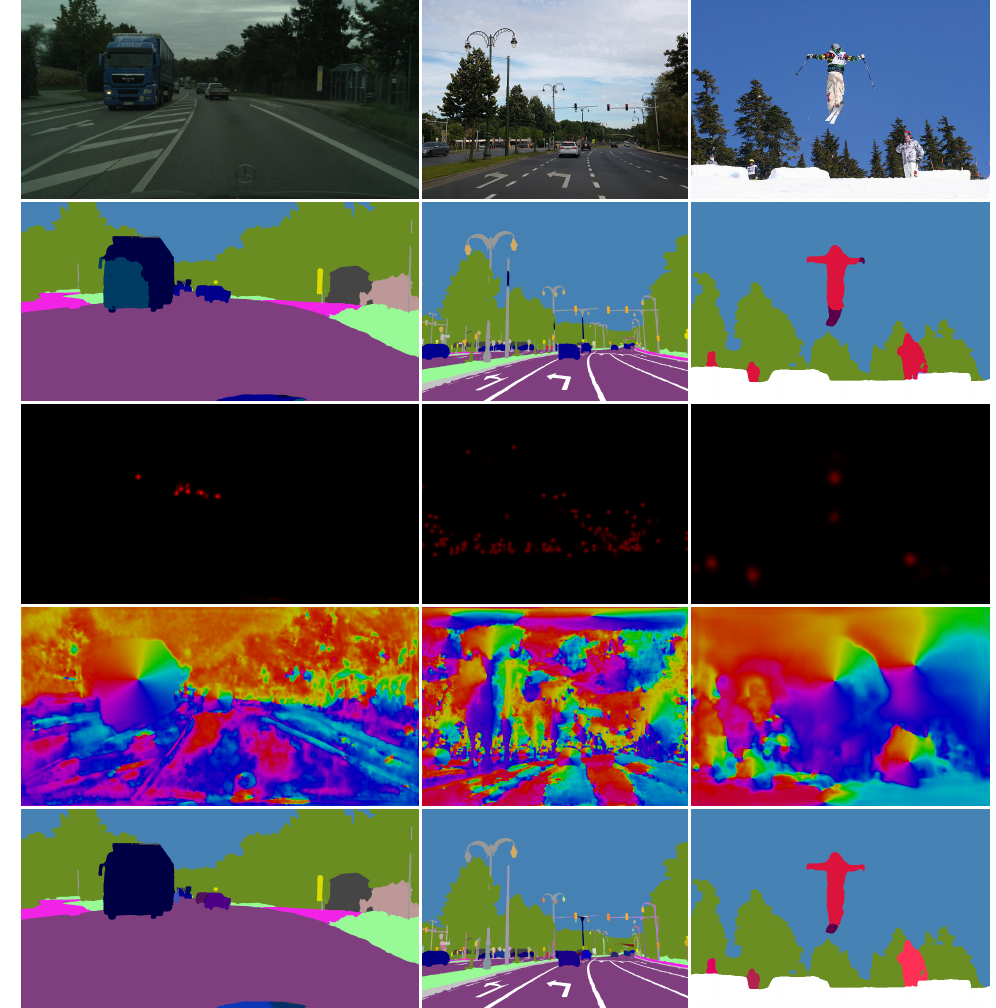
Figure 4. Qualitative results on three scenes from Cityscapes, Mapillary Vistas and COCO. Rows show: (first) input image, (second) semantic segmentation, (third) centers heatmap, (fourth) offset directions, and (fifth) panoptic